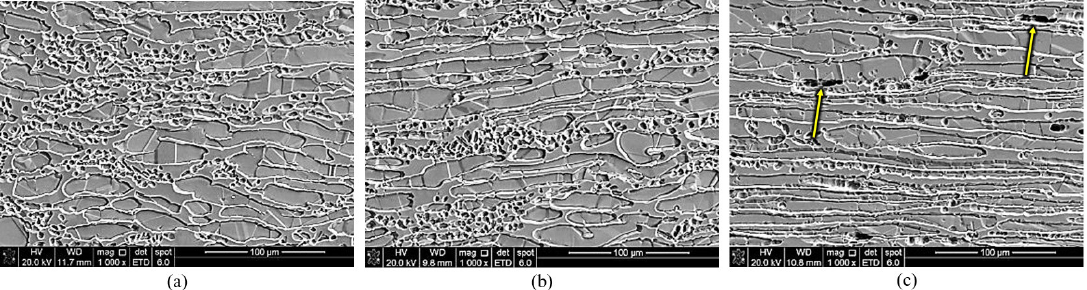
Figure 12. Results of ASTM A262 practice A. (a) 0.5 kJ.mm -1 HAZ (b); 1.0 kJ.mm -1 HAZ; (c) 3.5 kJ.mm -1 HAZ. Electrolytic etching in 10% oxalic acid solution, a current density of 1 A.cm -2 for 90 s at room temperature. A direct relationship of etching depth to welding energy is observed. The corrosive attack mainly consumes the ferrite matrix and reveal α/γ and γ twins interfaces. The ferrite phase suffers preferential corrosion for all conditions, especially lower energy welding. However, the 3.5 kJ.mm -1 HAZ showed a more prominent attack at the α/γ interfaces, generating cavities (see yellow arrows). This attack suggests some level of sensitisation at the α/γ interfaces. SEM, SEI.